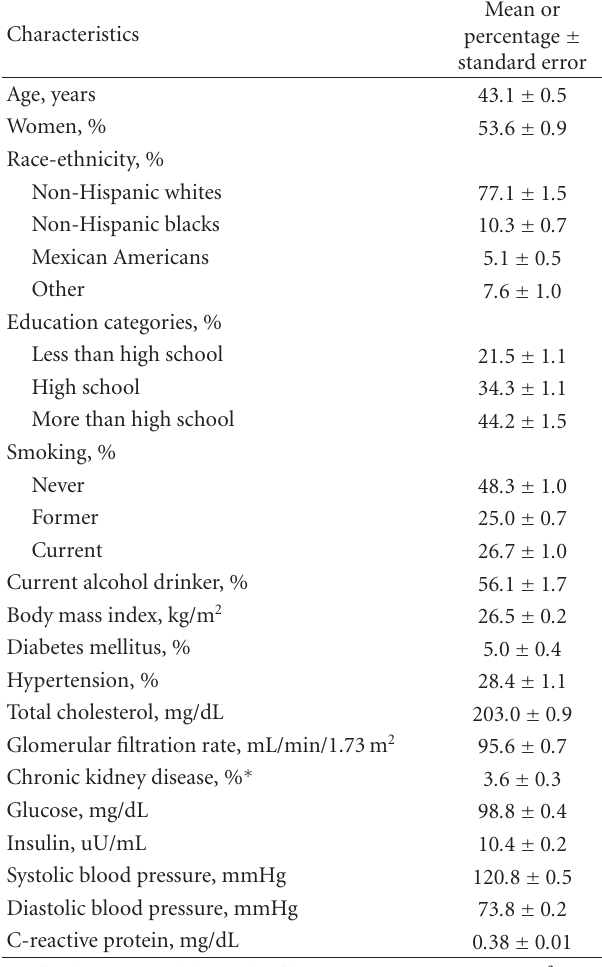
Table 1: Characteristics of the study population ( n =